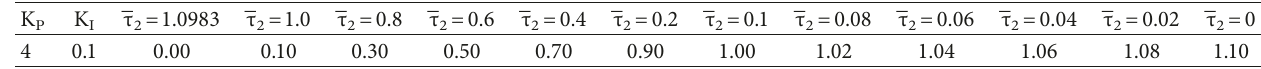
− 2, the highest acceptable delay bound τ ̅ 2